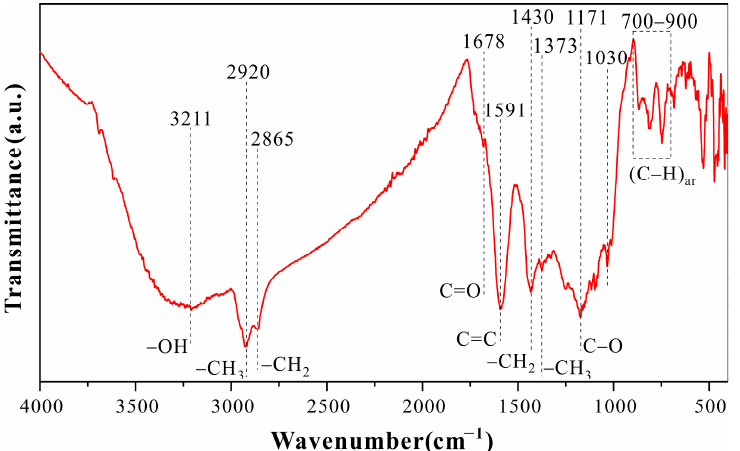
Figure 3. The Fouriertransform interferometric radiometer profile of the FK–3 coal with wavenumber assignments.